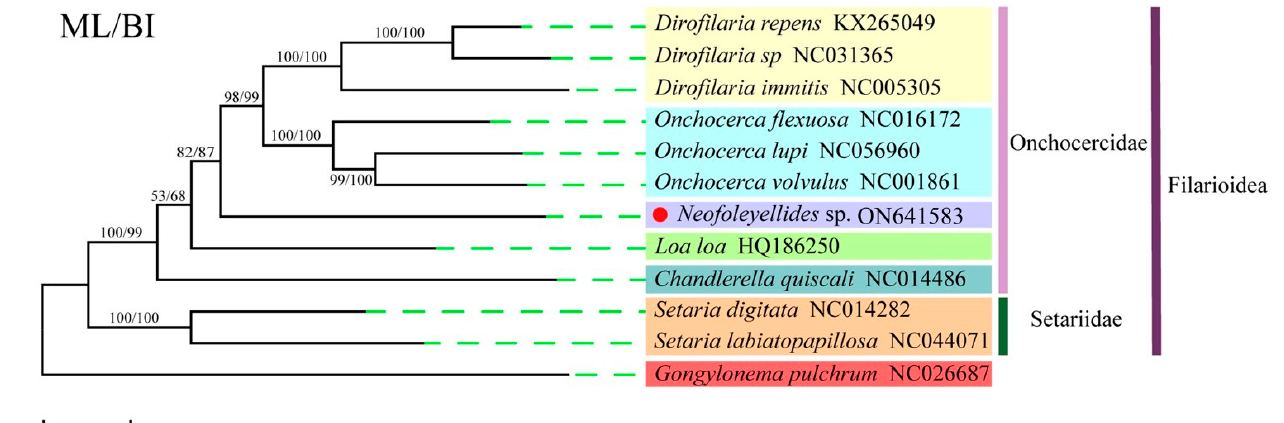
Figure 6. Phylogenetic reconstruction based on the concatenated amino acid sequences of 12 PCGs of 12 mitogenomes analyzed using the maximum likelihood and Bayesian inference methods. The sequenced specie of Neofoleyellides sp. in this study are marked with a red circle.